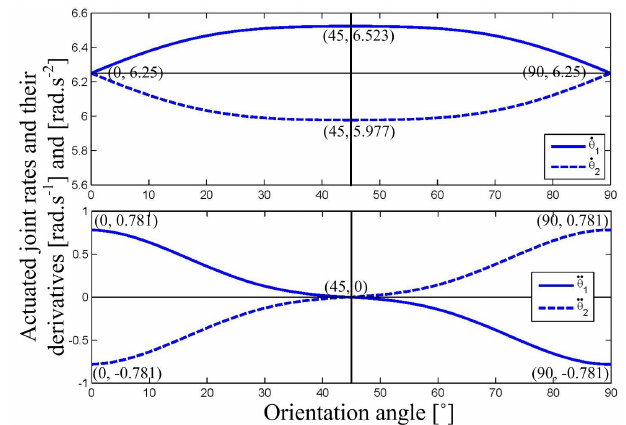
Figure 12. Actuated joint rates and angular accelerations on the Lamé